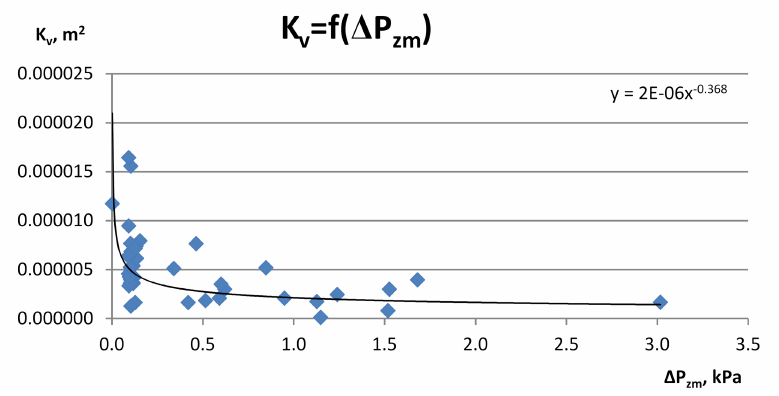
Figure 13. Effect of flow resistance ( ∆ P zm ) on the gas permeability coefficient ( K V ) of the adhesive bed-distribution of experimental poinds (own study).